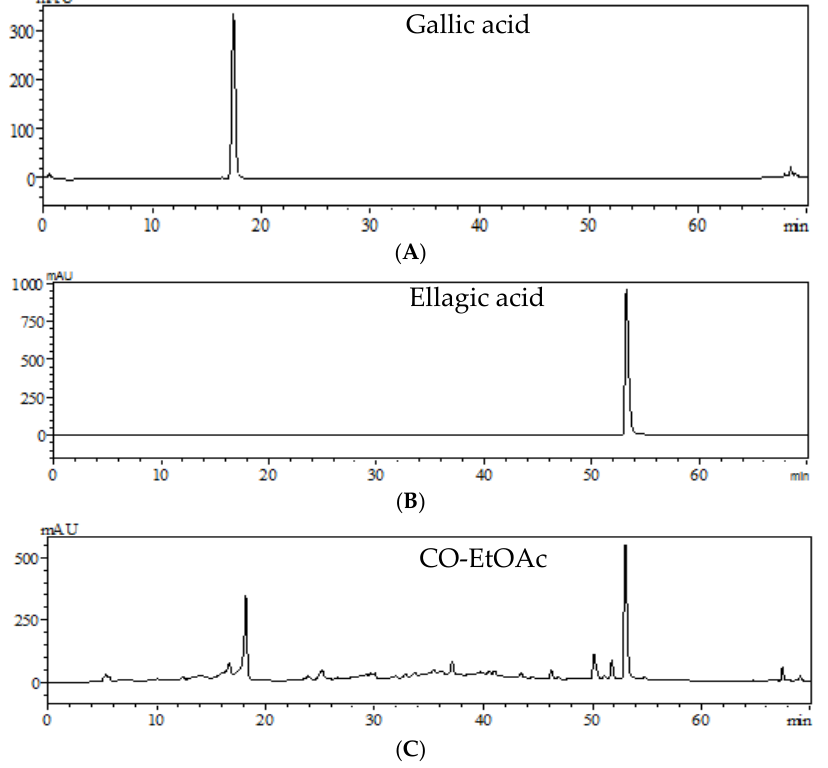
Figure 1. High performance liquid chromatography (HPLC) pattern of polyphenol standards and CO ‐ EtOAc: ( A ) HPLC chromatogram of standard reference: gallic acid (GA, 17.31 min); ( B ) standard reference: ellagic acid (EA, 53.22 min); and ( C ) HPLC chromatogram of CO ‐ EtOAc.